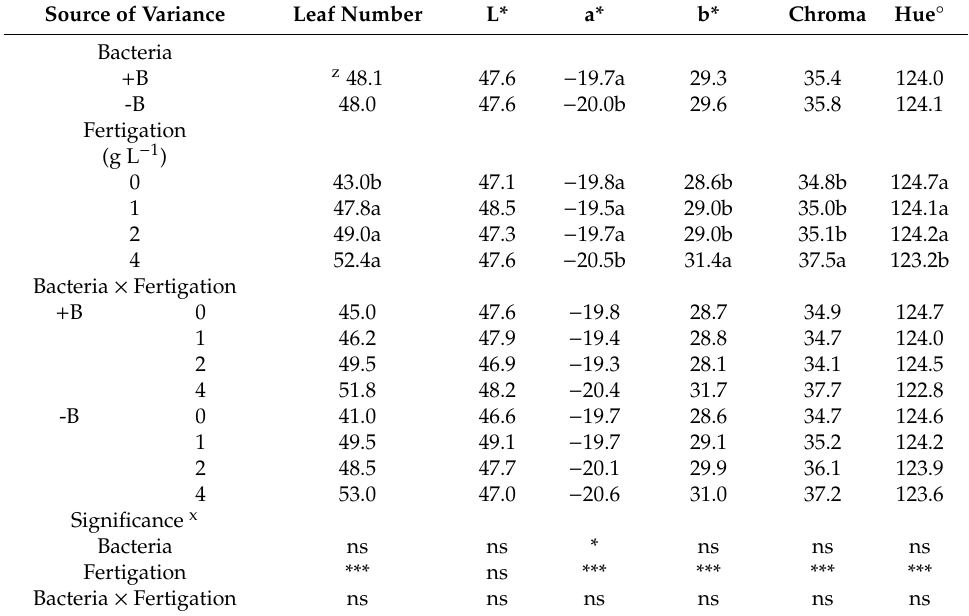
Table 4. E ff ects of the bacterial biostimulant (-B, not inoculated; + B, inoculated) and nursery fertigation rate (g L − 1 of NPK 20-20-20) during transplant production on leaf characteristics of lettuce plants grown in a